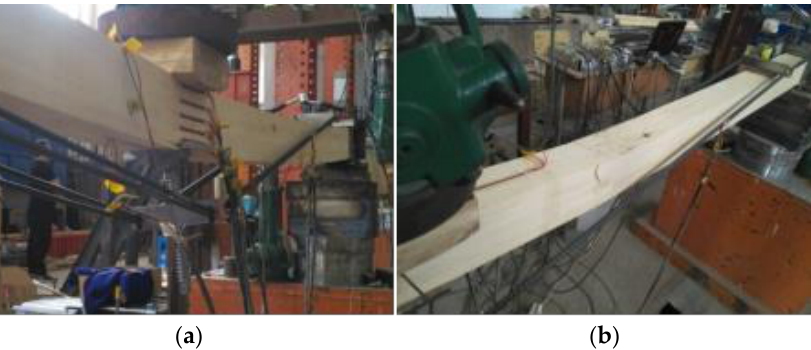
Figure 15. Failure mode of L A2 . ( a ) Overall instability of left span; ( b ) Compressive failure of right span.